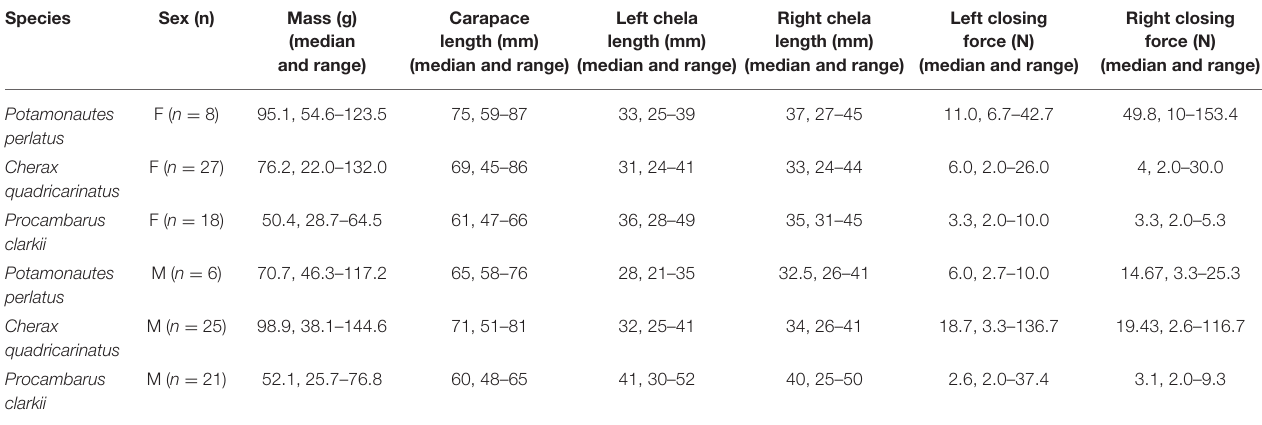
force (N) (median and range)